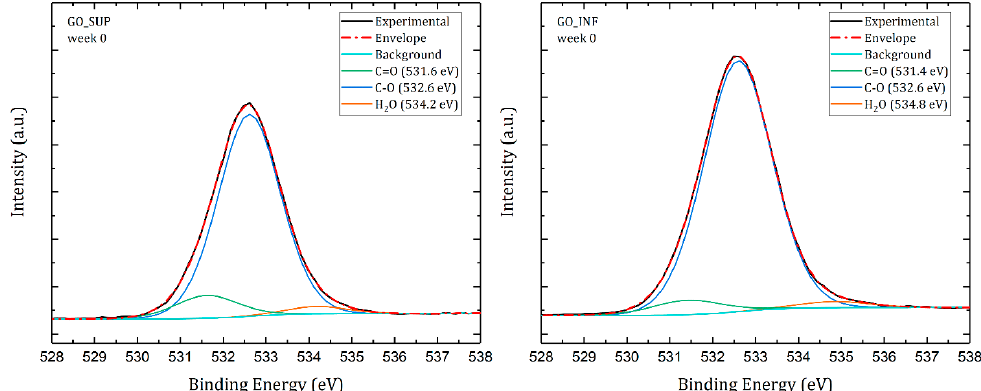
Figure 12. Deconvoluted O1s core-level XPS spectra of the dried GO_SUP ( left ) and GO_INF ( right ) samples obtained immediately after synthesis.